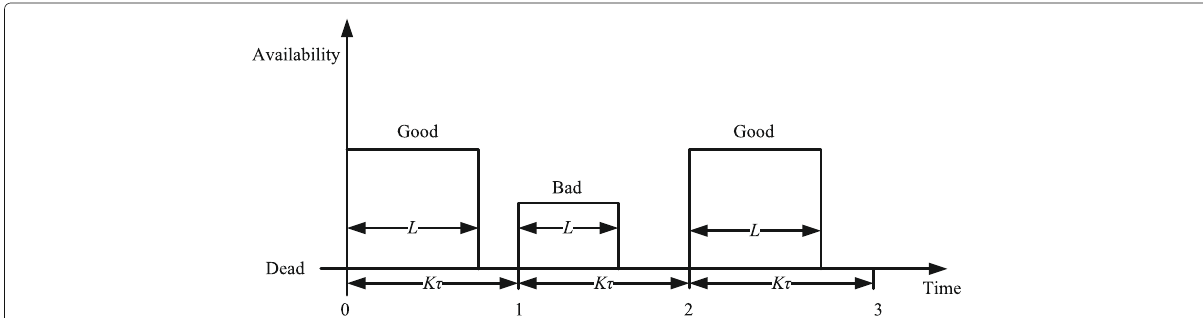
Fig. 1 Multi-state dying erasure channel model. MDEC model has three channel states, good, bad, and dead. The good and bad state transitions follow a semi-Markov process, and the duration of channel life span is random in one connective